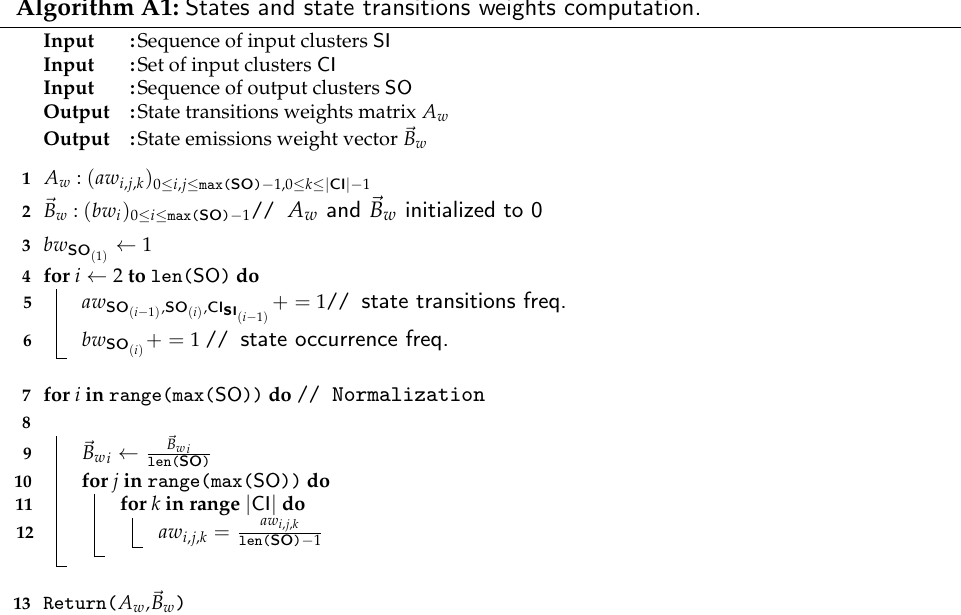
Algorithm A1: States and state transitions weights